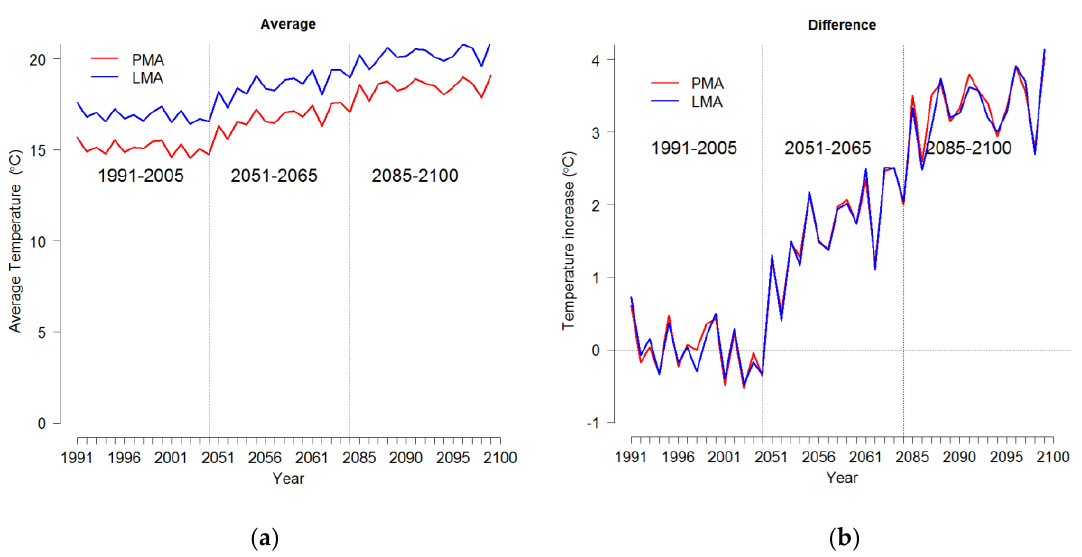
Figure 1. Time series plot of temperature in the PMA (Porto metropolitan area) and LMA (Lisbon metropolitan area) for the present/current period, 1991–2005 and future projections 2051–2065 and 2085–2099, ( a ) Average temperature, ( b ) Difference in temperature from historical average (1991– 2005).